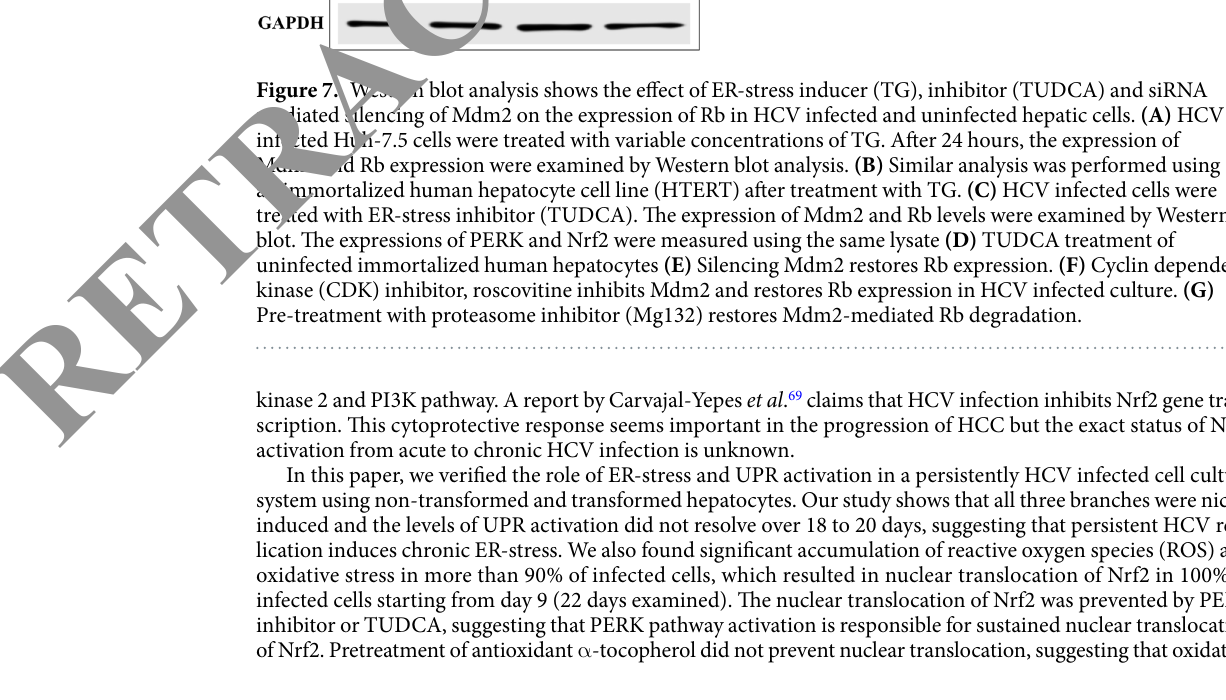
kinase 2 and PI3K pathway. A report by Carvajal-Yepes et al . 69 claims that HCV infection inhibits Nrf2 gene tran- scription. This cytoprotective response seems important in the progression of HCC but the exact status of Nrf2 activation from acute to chronic HCV infection is unknown. In this paper, we verified the role of ER-stress and UPR activation in a persistently HCV infected cell culture system using non-transformed and transformed hepatocytes. Our study shows that all three branches were nicely induced and the levels of UPR activation did not resolve over 18 to 20 days, suggesting that persistent HCV rep- lication induces chronic ER-stress. We also found significant accumulation of reactive oxygen species (ROS) and oxidative stress in more than 90% of infected cells, which resulted in nuclear translocation of Nrf2 in 100% of infected cells starting from day 9 (22 days examined). The nuclear translocation of Nrf2 was prevented by PERK inhibitor or TUDCA, suggesting that PERK pathway activation is responsible for sustained nuclear translocation of Nrf2. Pretreatment of antioxidant α -tocopherol did not prevent nuclear translocation, suggesting that oxidative